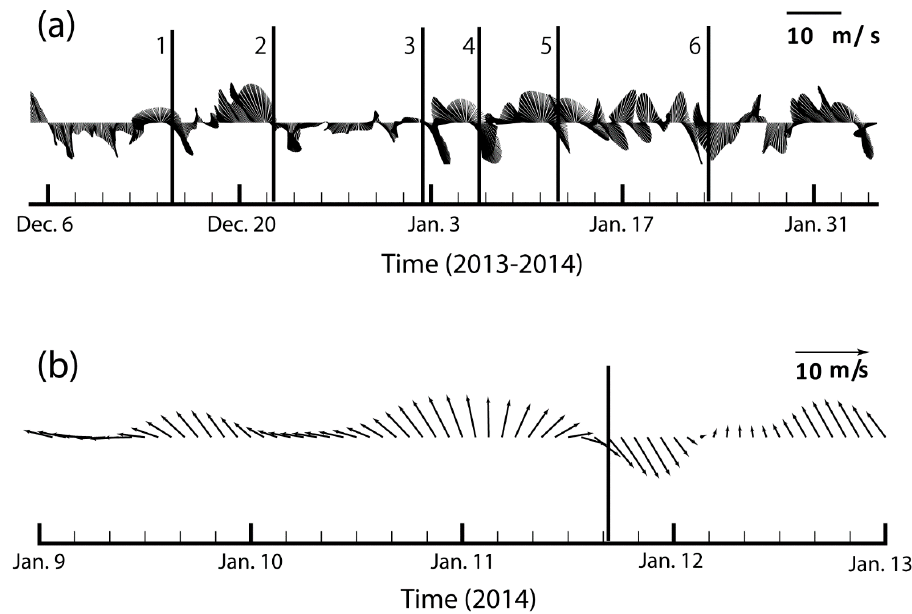
Figure 6. Time series wind vector ( a ) between 4 Dec. 2013 and 4 Feb. 2014; the vertical bars indicate the timing of the six major cold frontal passages; ( b ) a typical cold front process; the vertical line indicates the time of the 5th atmospheric frontal passage.